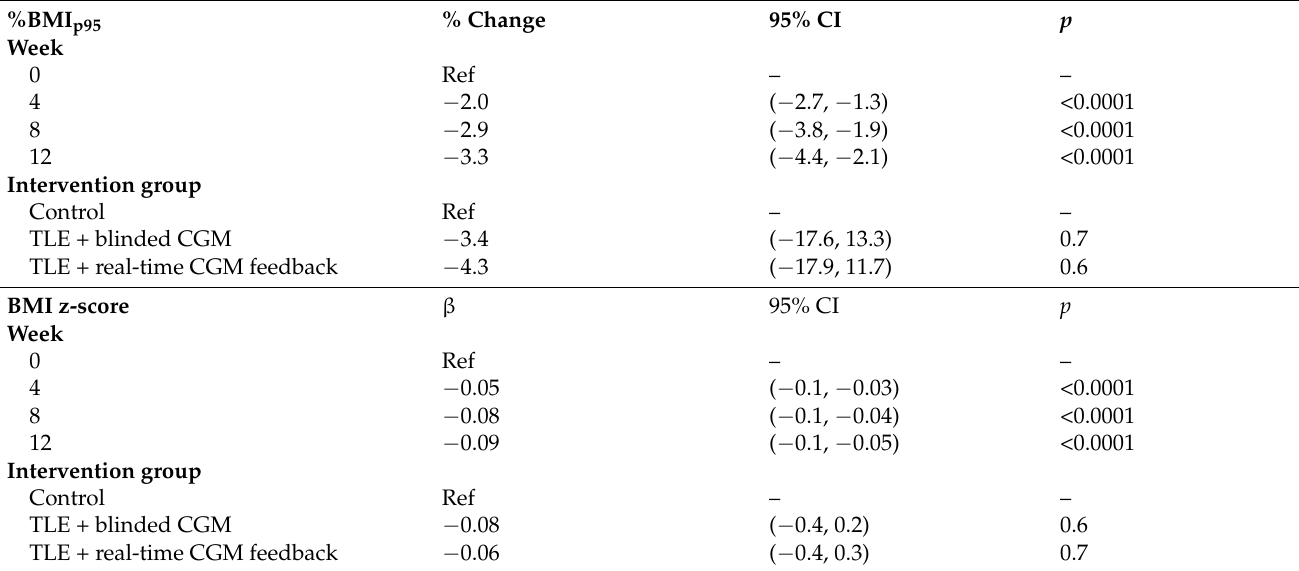
Table 4. Gamma mixed-effects generalized linear model on %BMI p95 and BMI